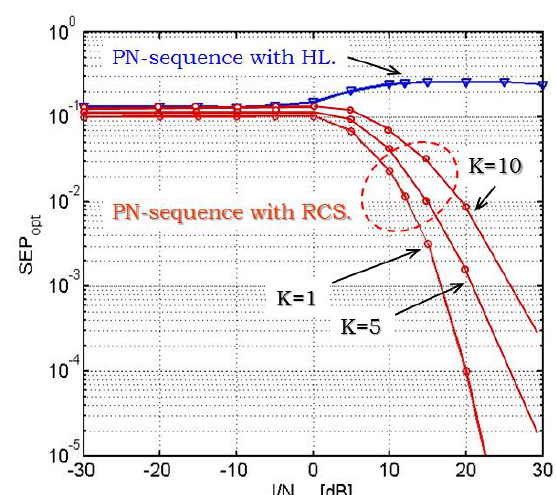
Fig. 8. Performance comparison: PN-signature with HL-detection (K=1) and PN-signature with RCS assisted detection for K active